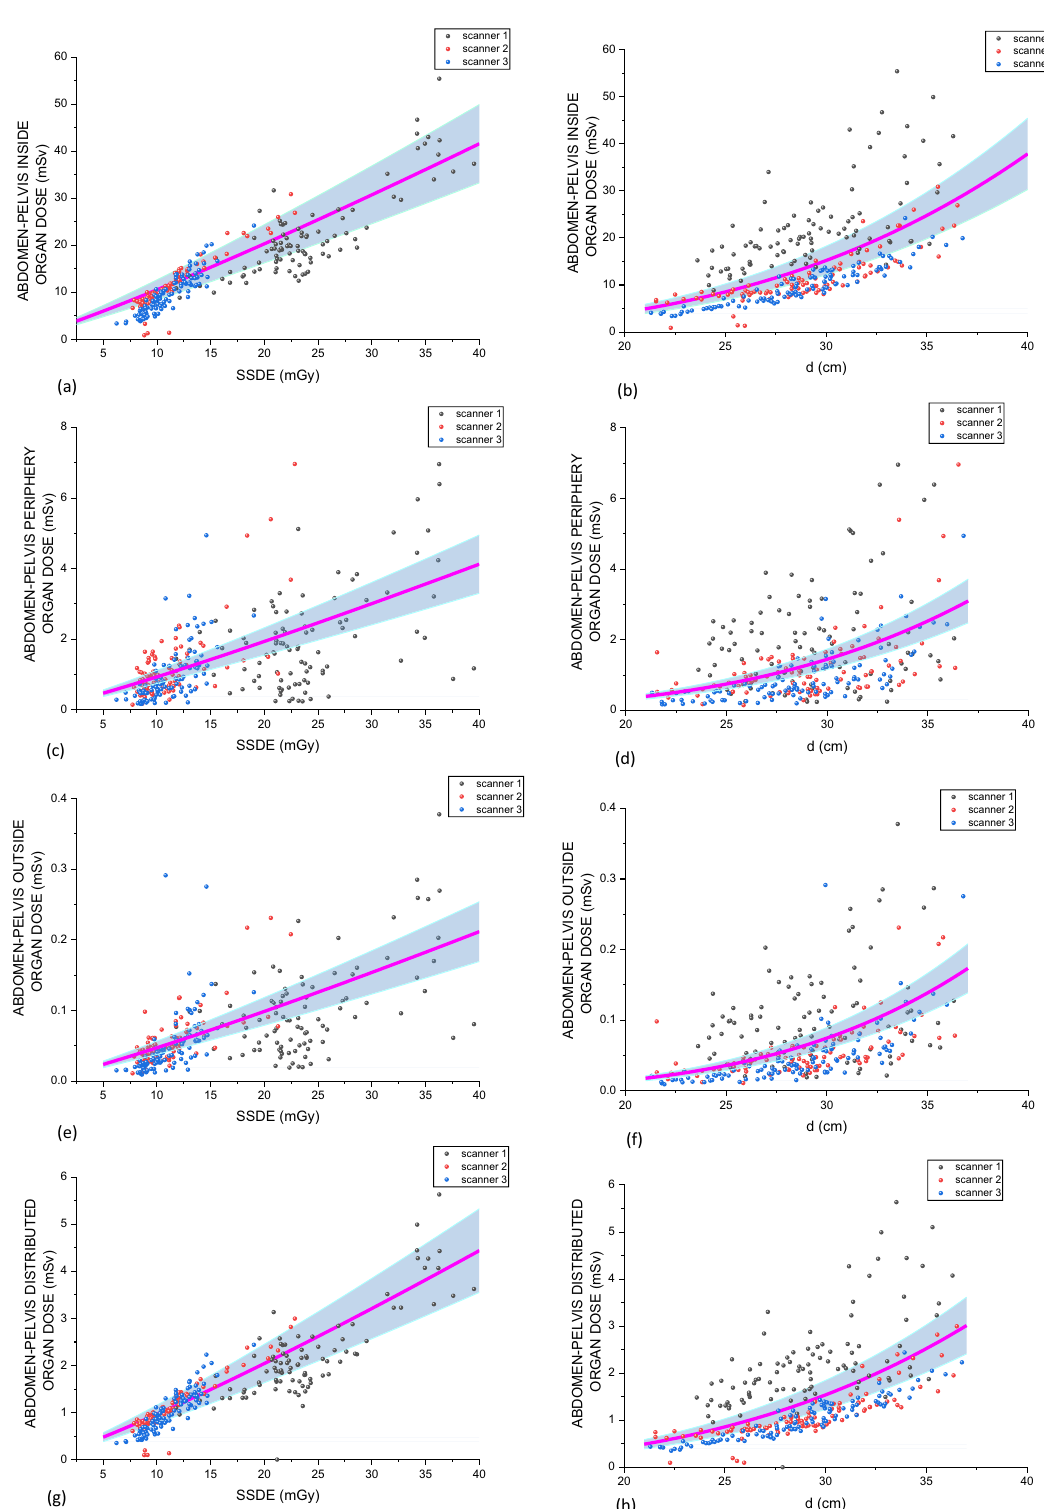
Fig. 3 Abdomen-pelvis organ dose groups as functions of the SSDE (( a ) Inside, ( c ) Periphery, ( e ) Outside and ( g ) Distributed) and d (( b ) Inside, ( d ) Periphery, ( f ) Outside and ( h ) Distributed). The magenta lines correspond to the fittings using Eq. (2) considering the contributions of patients imaged in all CT scanners. The blue band refers to a range of 20% around this average line. The dots identify each CT scanner used in the ±